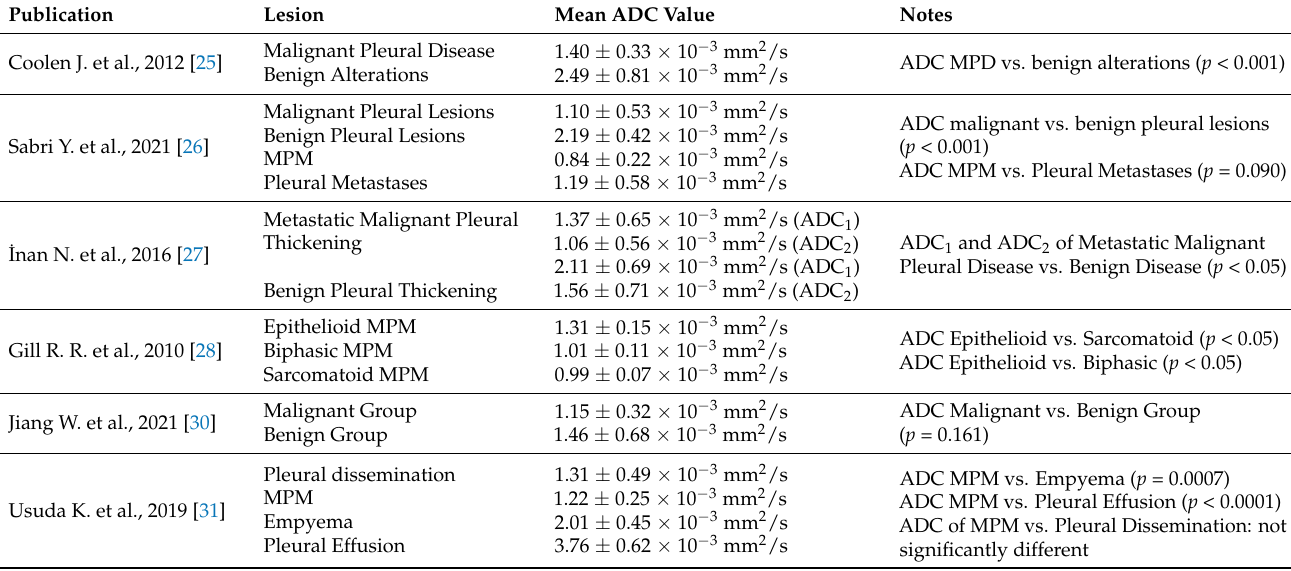
Table 2. Main paper with relative apparent diffusion coefficient (ADC). MPM: malignant pleural mesothelioma. MPD: malignant pleural